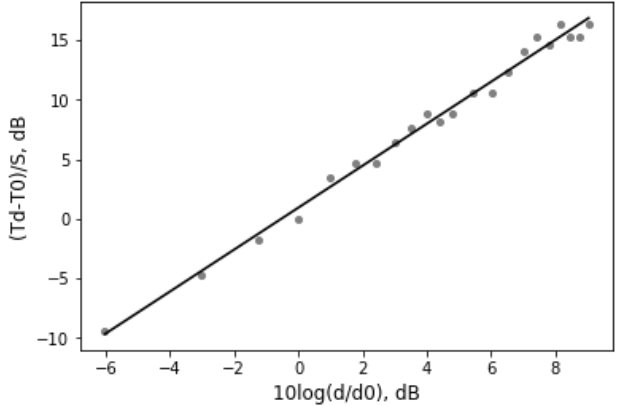
Fig. 3. Threshold difference ( 𝑇 d − 𝑇 0 ) S as a function of 10lg( d/d 0 ) in